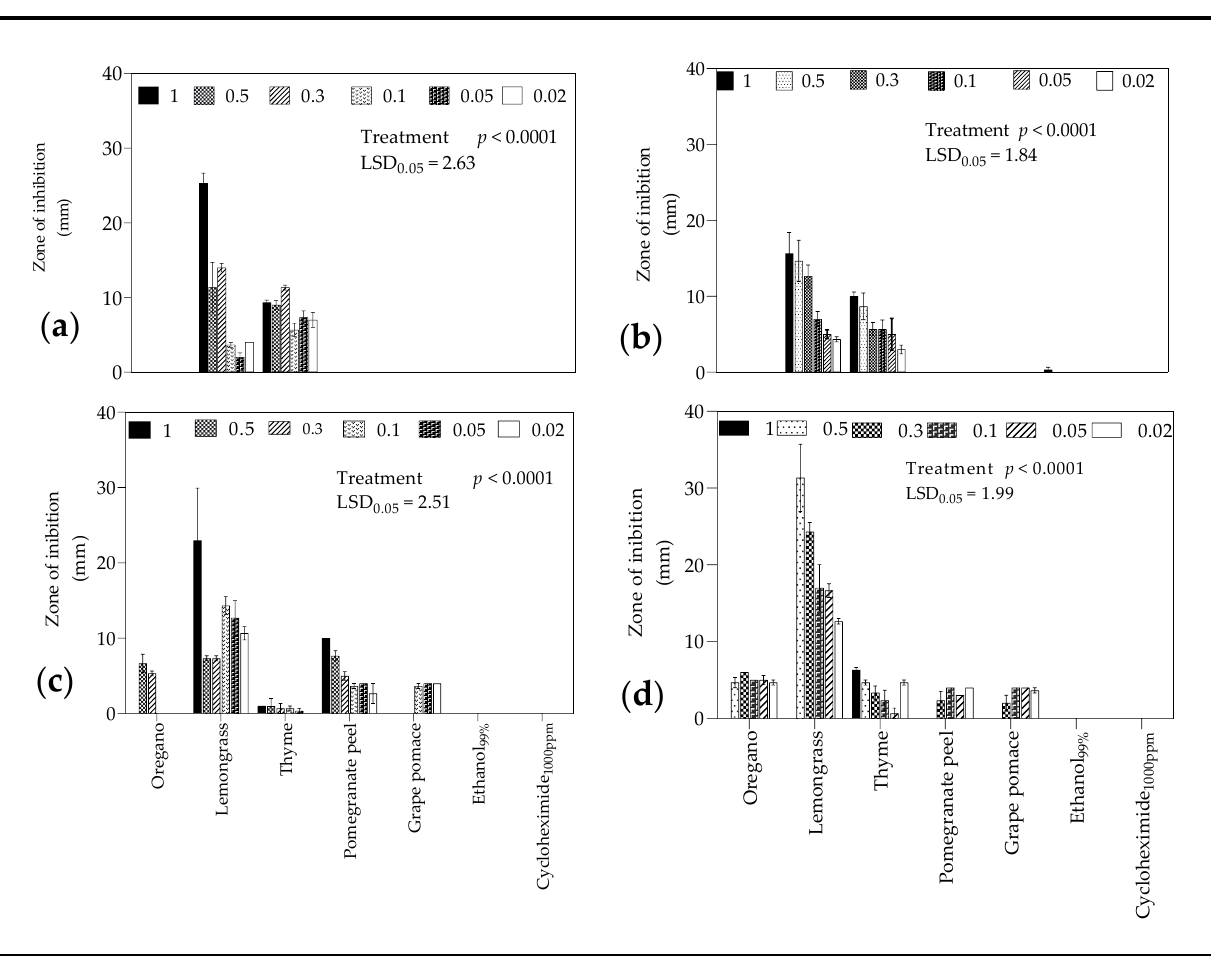
Figure 1 . Zone of inhibition (mm) of Botrytis cinerea ( a , c ) and Penicillium spp. ( b , d ) as determined by disc ( a and b ) and well ( c , d ) diffusion test methods in plates treated with different concentrations (0.02–1 µL/mL) of essential oils and plant extracts. Plates were inoculated with a spore suspension (1 × 10 9 spores·L −1 ) of the test organism ( B. cinerea and Penicillium spp.) Ethanol (99.9%) and cycloheximide (1000 ppm) were used as controls. Vertical bars represent the standard error (SE) of mean values of three replicates (1 plate = replicate). LSD 0.05 represent least significant difference ( p < 0.05).